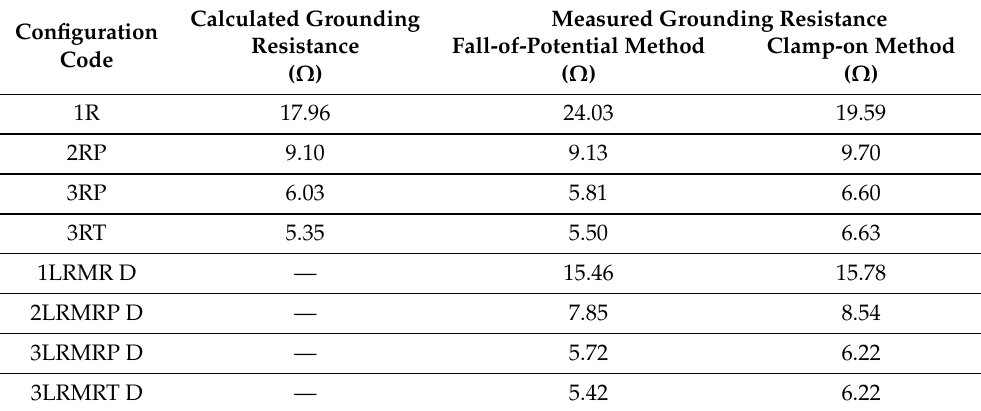
Table 4. GR calculations and measurements in S2.